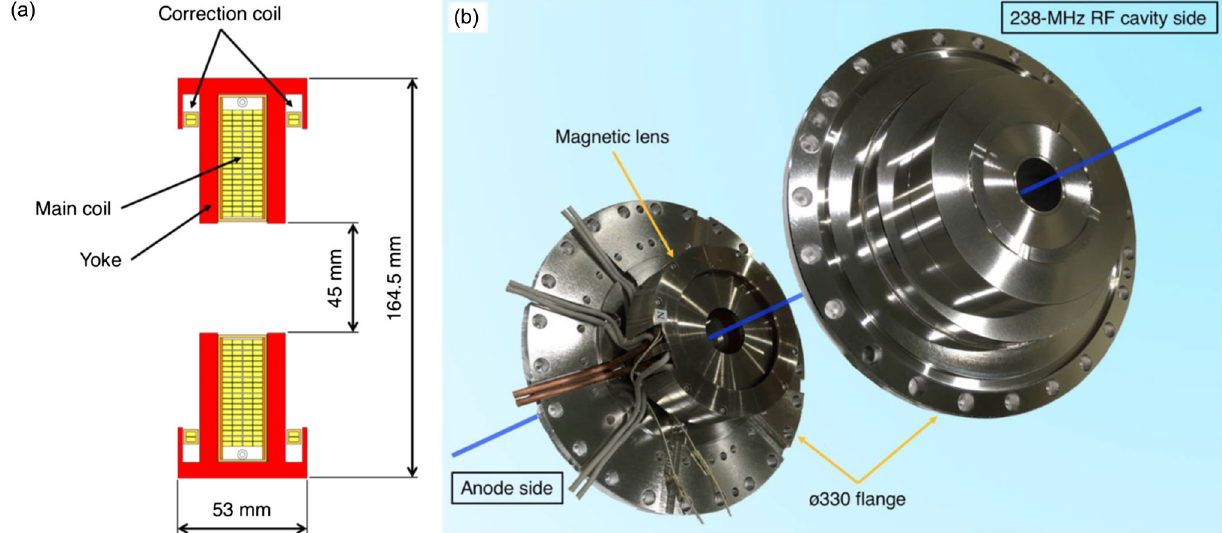
FIG. 5. (a) Cross section of the magnetic lens with the correction coils and (b) metal casing enclosing the magnetic lens.